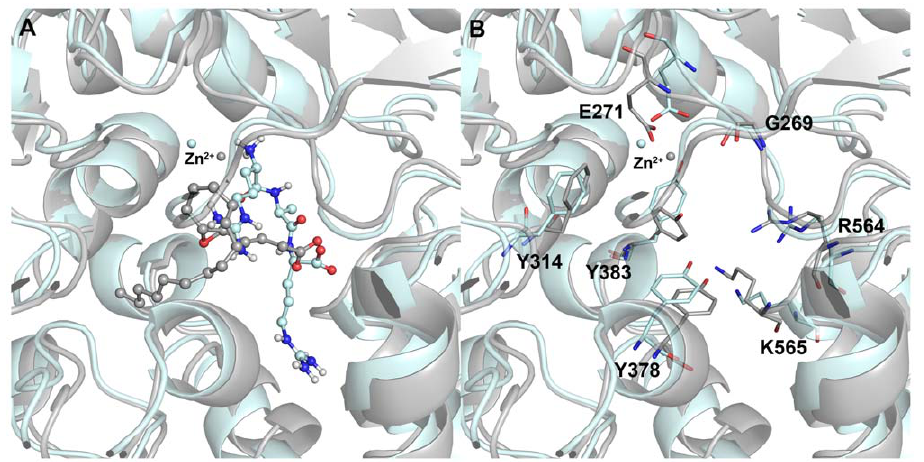
Figure 11. The binding modes of two substrates in the active site of the WT enzyme. (A) LTA4 and RAR substrates shown in grey and cyan at the active site (B) the catalytic active site residues are shown in thin stick